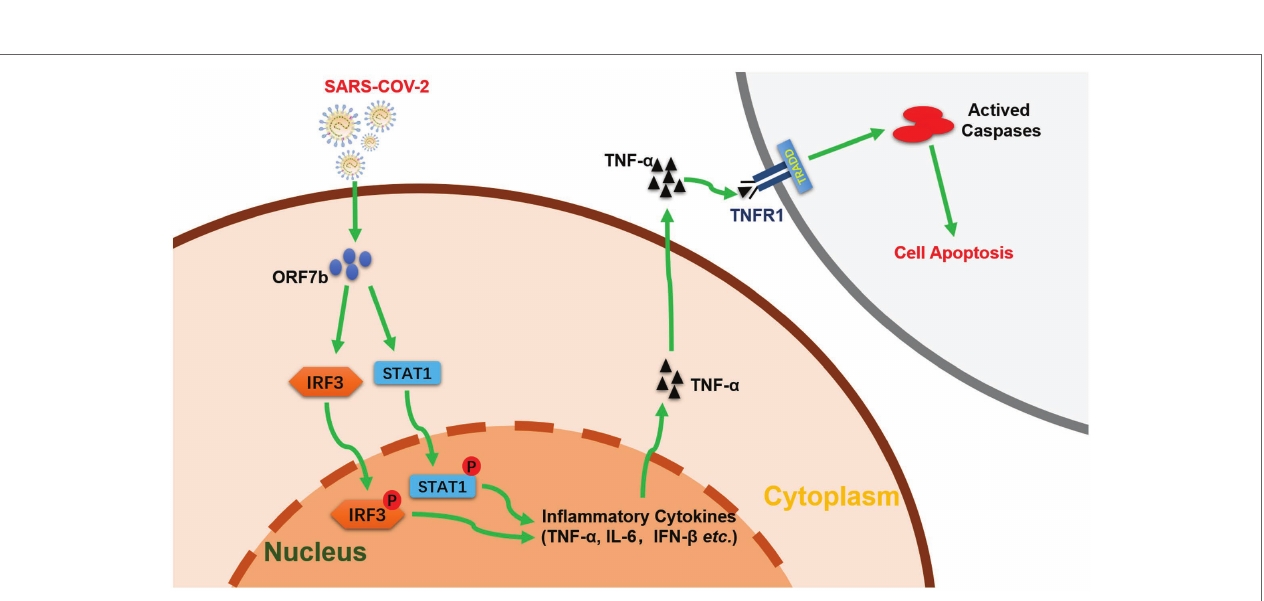
FIGURE 5 | Function and pathway of ORF7b in cell apoptosis (schematic). ORF7b promotes the phosphorylation of IRF3 and STAT1, which translocate to the nucleus and activate TNF- α secretion, thereby resulting in cellular apoptosis through TNFR1 pathways.